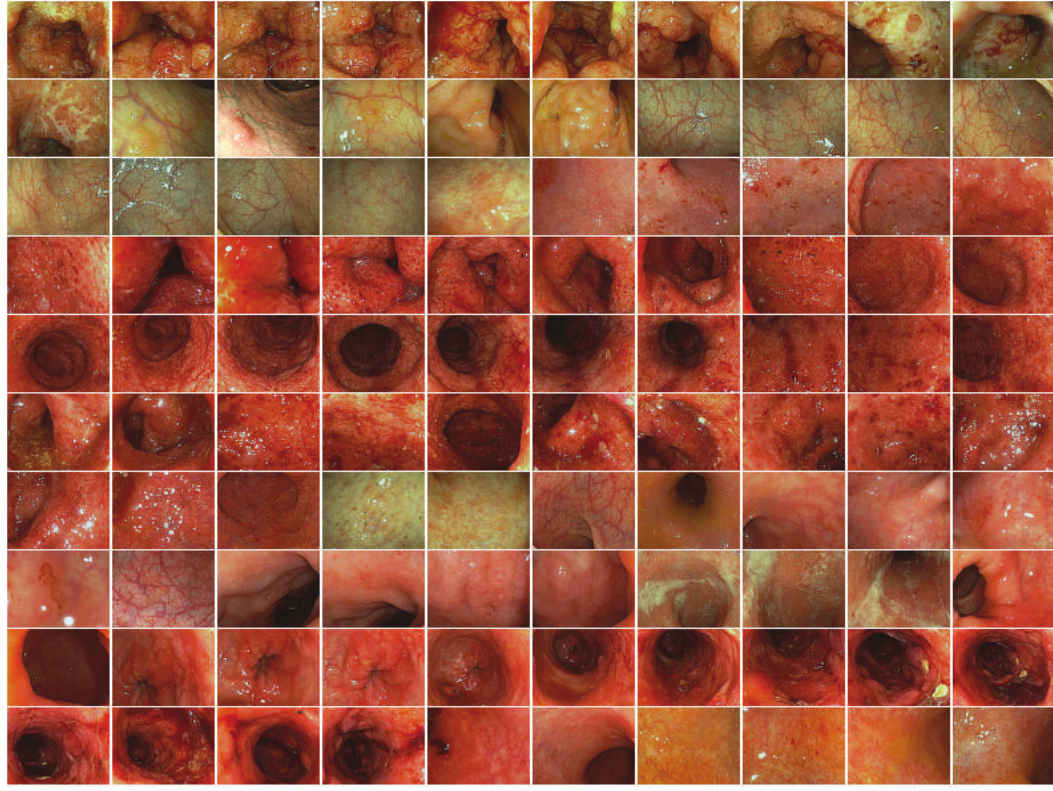
Figure 15: The 100 retrieval target images, which are the actual colonoscopy